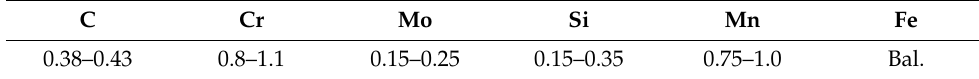
Table 1. Chemical properties of 42CrMo steel (wt%).